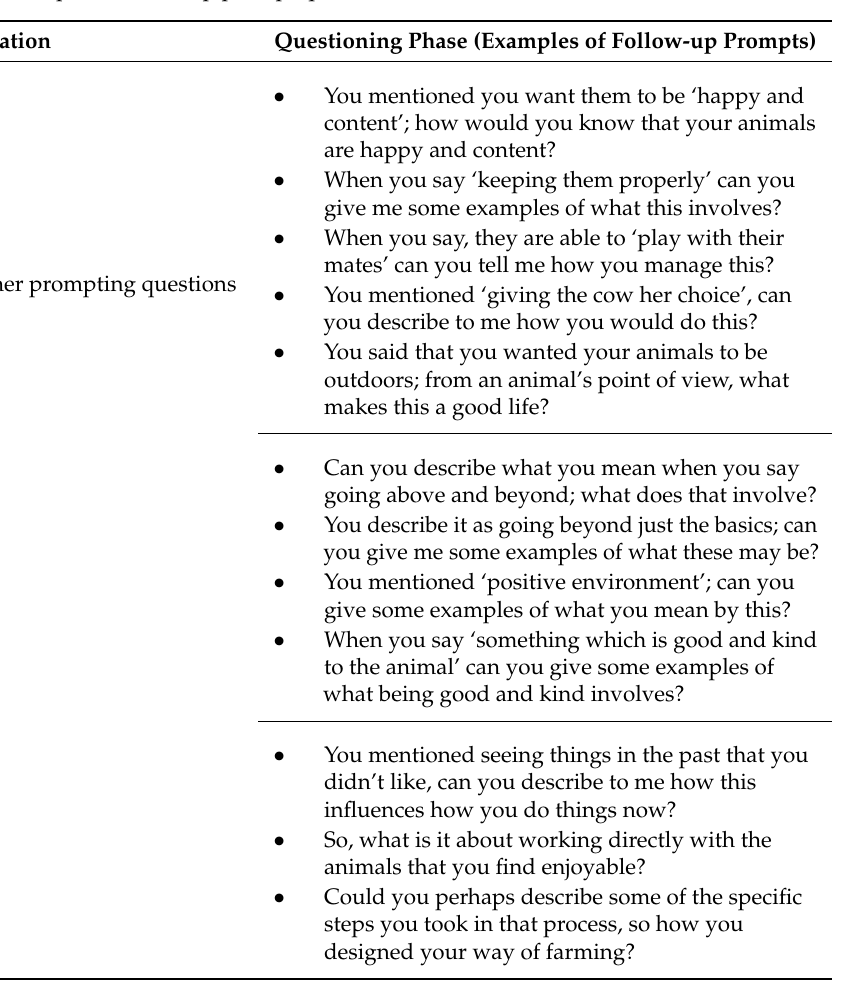
Table A1. Format of narrative interviews with example of follow-up prompt